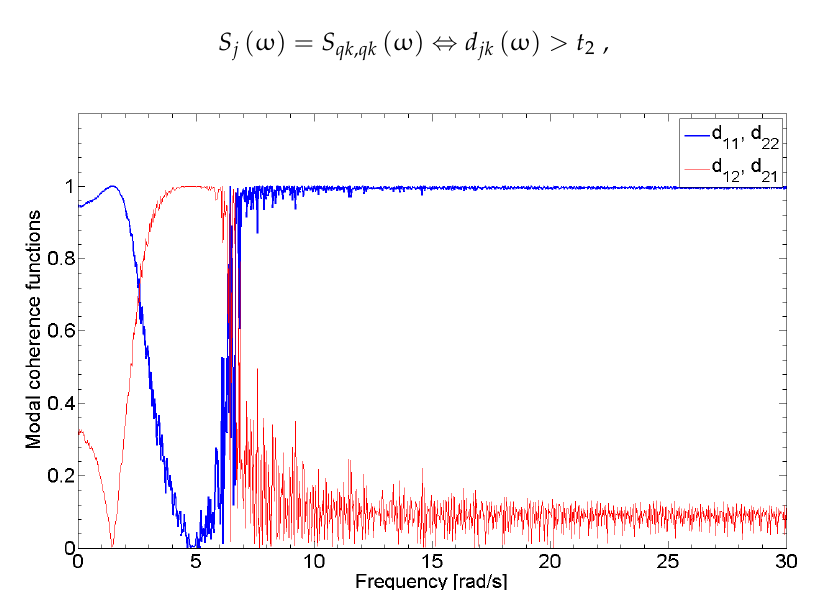
Figure 2. Modal coherence functions for a sample 2 ‐ DOF system.